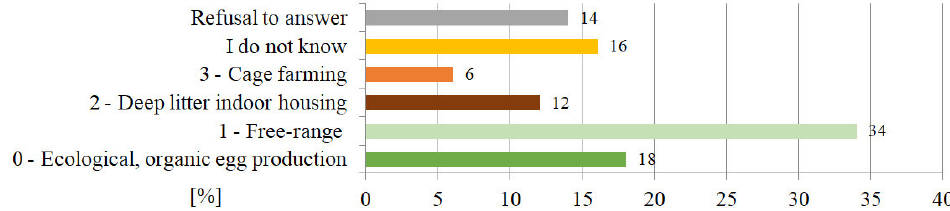
Figure 2. Respondents’ preferences of eggs selection [%] regarding hen rising method.